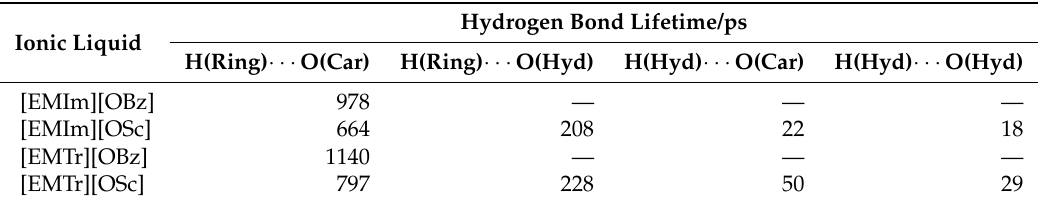
Table 2. Computed intermittent hydrogen bond lifetimes from the MD simulations at 80 ◦ C. An O · · · H distance criterion of 300pm was used to define hydrogen bonds. For the atom labels, see Figure 1. Ionic Liquid